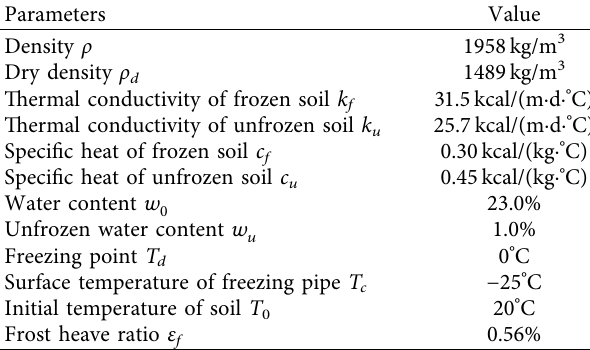
Table 2: Parameters of